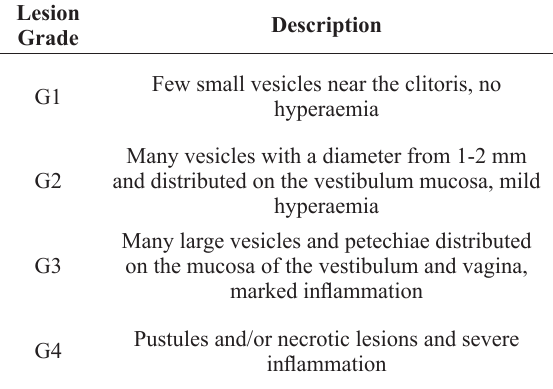
Characterization of Vaginal Lesion Score